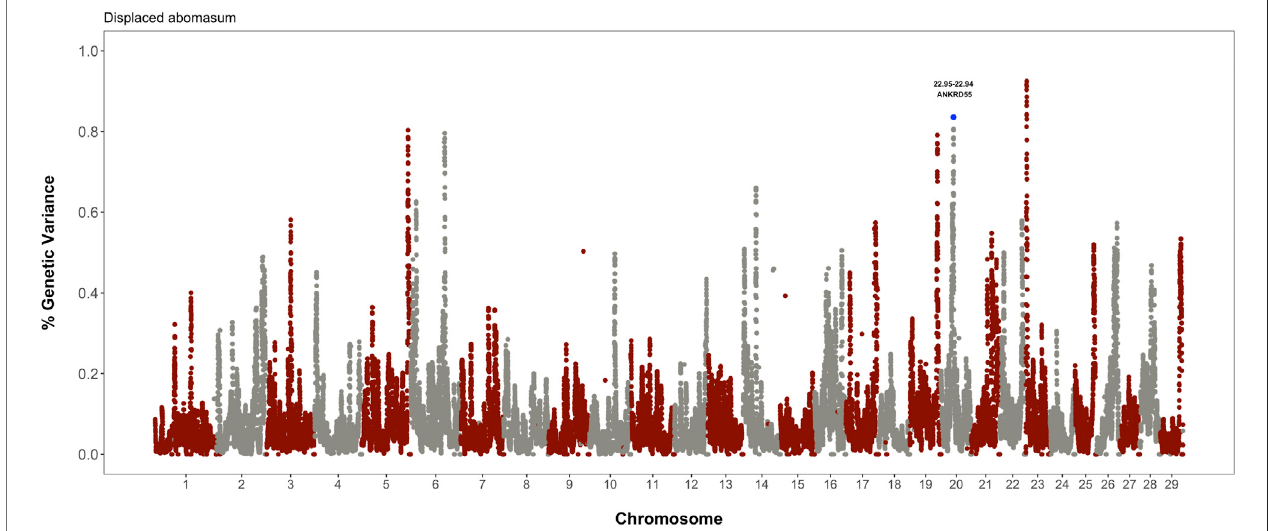
FIGURE 3 | Whole-genome scan for incidence of displaced abomasum: percentage of additive genetic variance explained by 2.0 Mb SNP-windows across the entire bovine genome. Candidate gene ANKRD55 is implicated in both visceral fat accumulation and displaced abomasum.